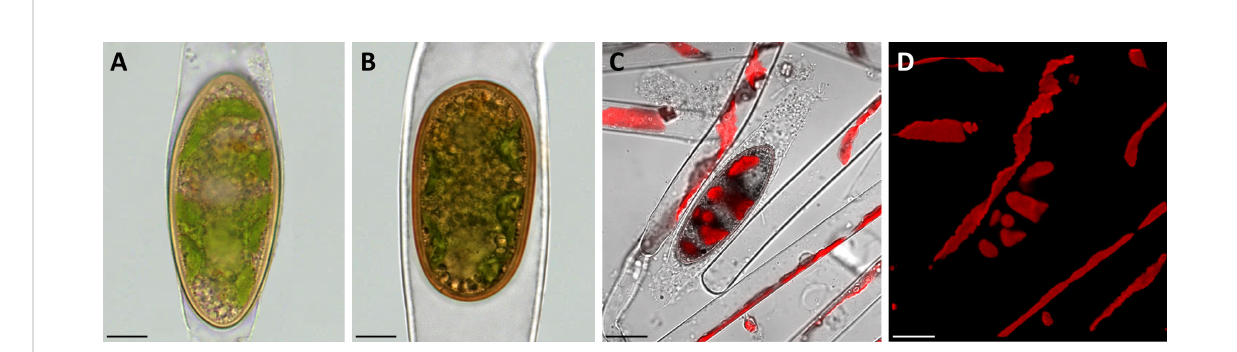
FIGURE 1 Morphological characterization of Spirogyra zygospores by light and confocal laser scanning microscopy. (A, B) light micrographs; (C, D) confocal laser scanning micrographs (z-stack projections). (A) Spirogyra sp. zygospore inside the swollen female gametangium; (B) Spirogyra mirabilis zygospore inside the female gametangium; (C) bright fi eld image (Chanel D) merged with chlorophyll auto fl uorescence (505 nm Long- pass, false colored red) with (D) corresponding chlorophyll auto fl uorescence (red) of Spirogyra sp. vegetative fi laments and zygospore. Scale bars: (A, B) 10 µm; (C, D) 20 µm.